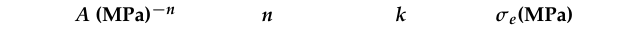
Table 1. Parameters in the model (Equation (15)).